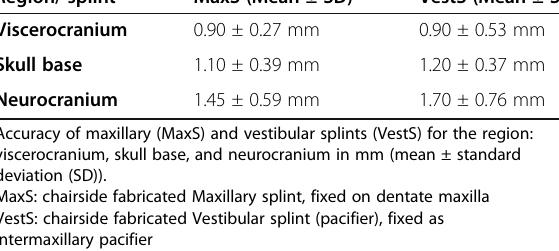
Table 1 Accuracy of two oral splints for guided surgery in different regions of the head Region/ splint